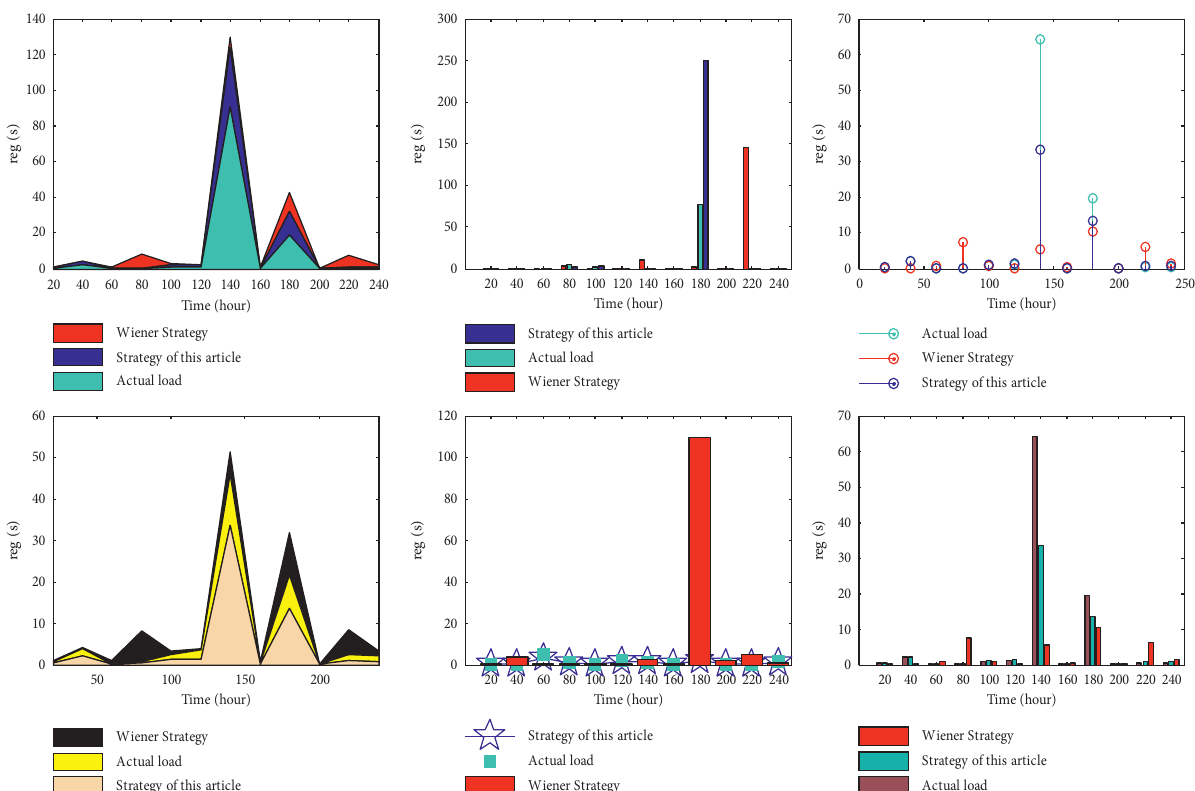
Figure 7: The economic big data workload and distributed storage effect of the 6 load generators in the